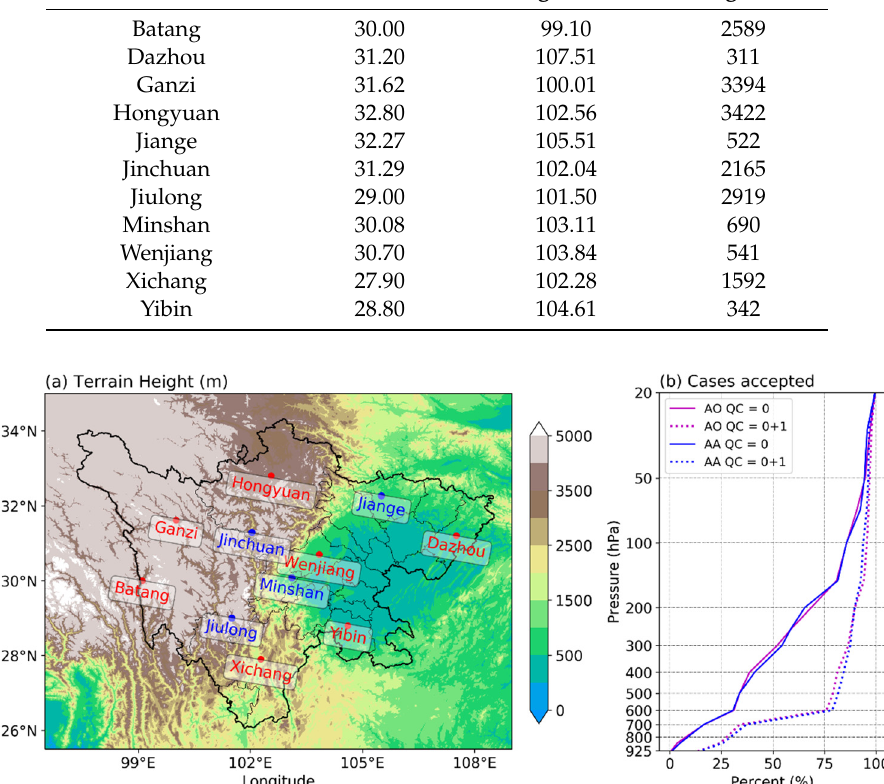
Figure 1. ( a ) Topographic height in the lee of the TP and the position of radiosonde sites, blue (red) words indicate intensive (operational) radiosonde sites; ( b ) percentage of sample numbers of Atmospheric Infrared Sounder (AIRS) at different quality control levels, from 20 June to 31 July from 2011 to 2016. The solid lines show ‘best’ quality (quality control (QC) = 0) data and the dashed lines show ‘good’ quality (QC = 1) data. The AA indicates the AIRS/Advanced Microwave Sounding Unit (AMSU) products and AO indicates the AIRS-only products.